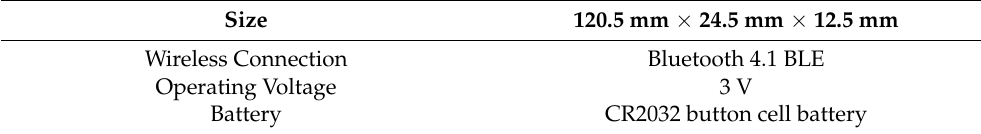
Figure 5. Sensor installation placement.